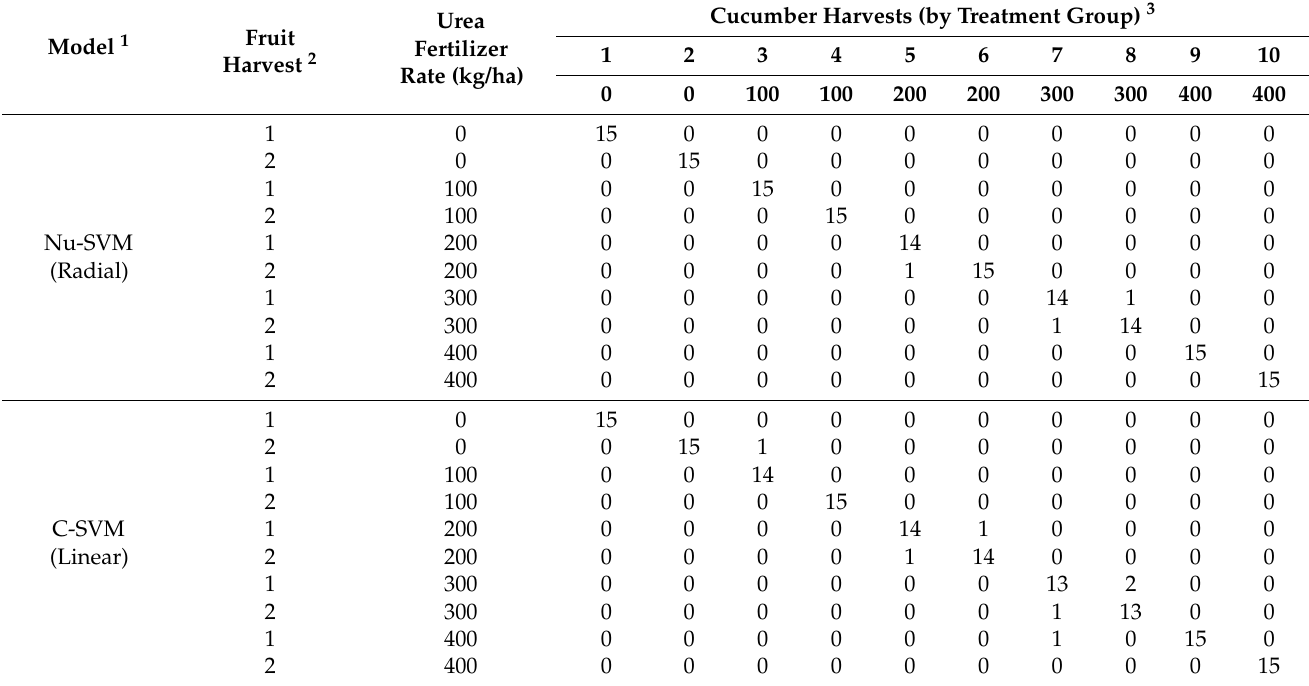
Table 5. Confusion matrix for 10 groups of cucumbers based on the amount of urea fertilizer classification using the SVM statistical